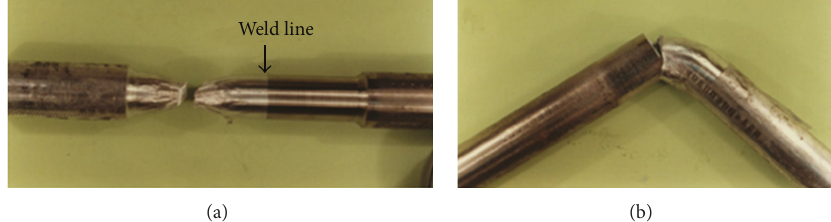
Figure 4: View of friction welded joints of AlMgSi0.5 aluminium alloy-X10CrNiTi189 austenitic steel, after the static tensile test (a) and the technological bending test (b).